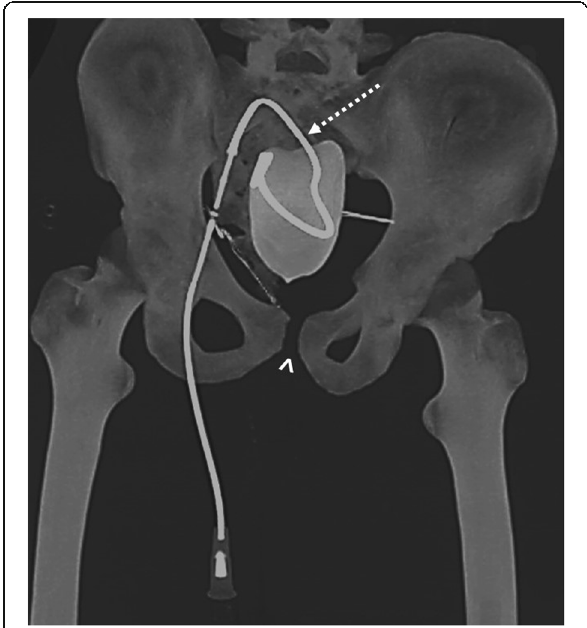
Fig. 1 Patient ’ s conditions after admission to our hospital — MDTC 3D-MIP reconstructions showing pubic symphysis diastasis (head of white arrow) and epicystostomy (discontinued white